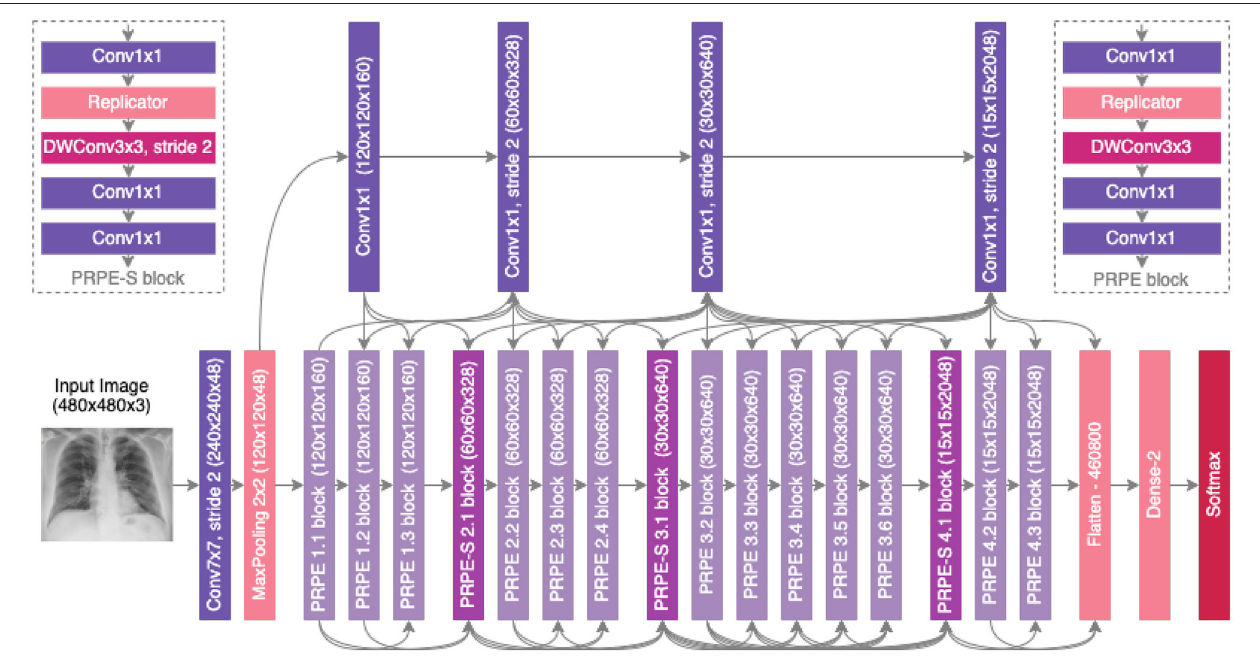
FIGURE 4 | The proposed COVID-Net CXR-2 architecture design. The COVID-Net design exhibits high architectural diversity and sparse long-range connectivity, with macro and microarchitecture designs tailored specifically for the detection of COVID-19 from chest X-ray images. The network design leverages light-weight design patterns in the form of projection-replication-projection-expansion (PRPE) patterns to provide enhanced representational capabilities while maintaining low architectural and computational